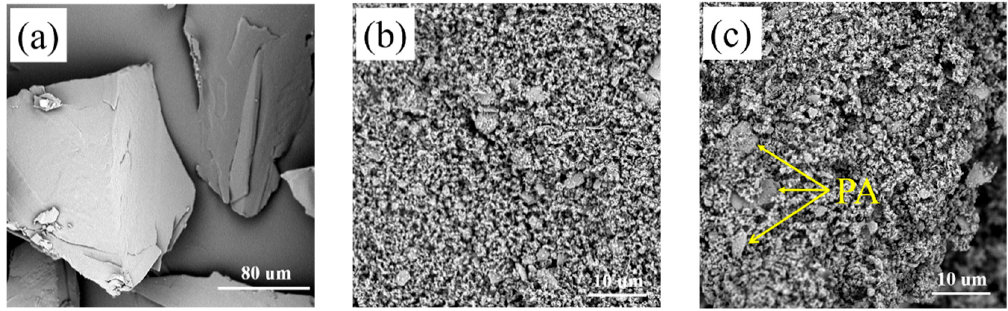
Figure 4. Scanning Electron Microscope (SEM) images of ( a ) PA, ( b ) mullite and ( c ) PA/mullite.